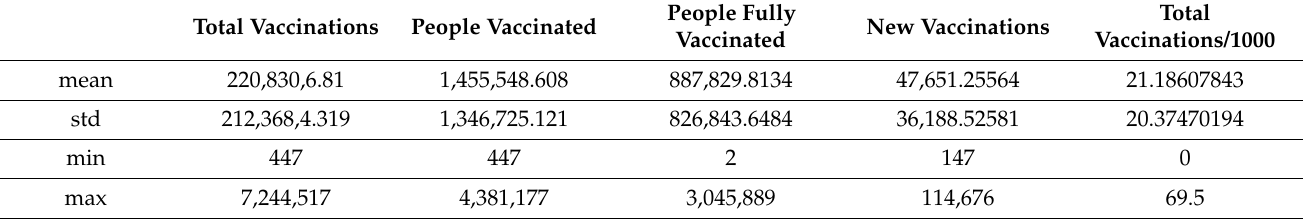
Table 3. Pandemic Statistic Analysis_3.